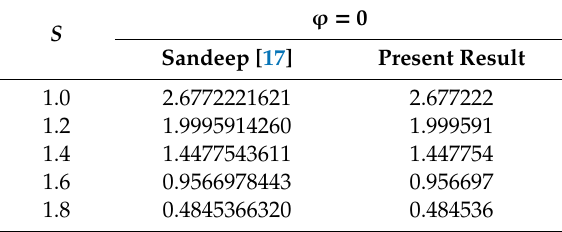
Table 3. The comparison table of – θ ’(0) with Sandeep [17] for varied estimates of S when R = M = γ = 0, P r =